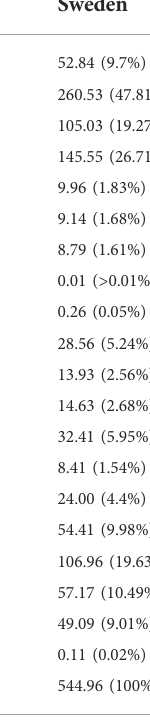
TABLE 1 Absolute and relative use of different antibiotic subgroups in the elderly population in Hungary and